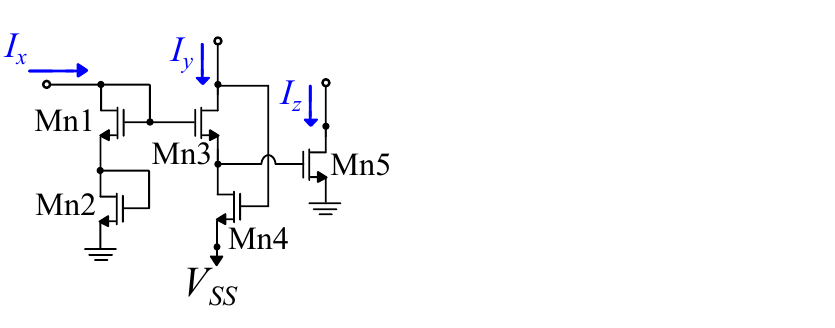
Figure 8. An example transistor level implementation of a squarer divider